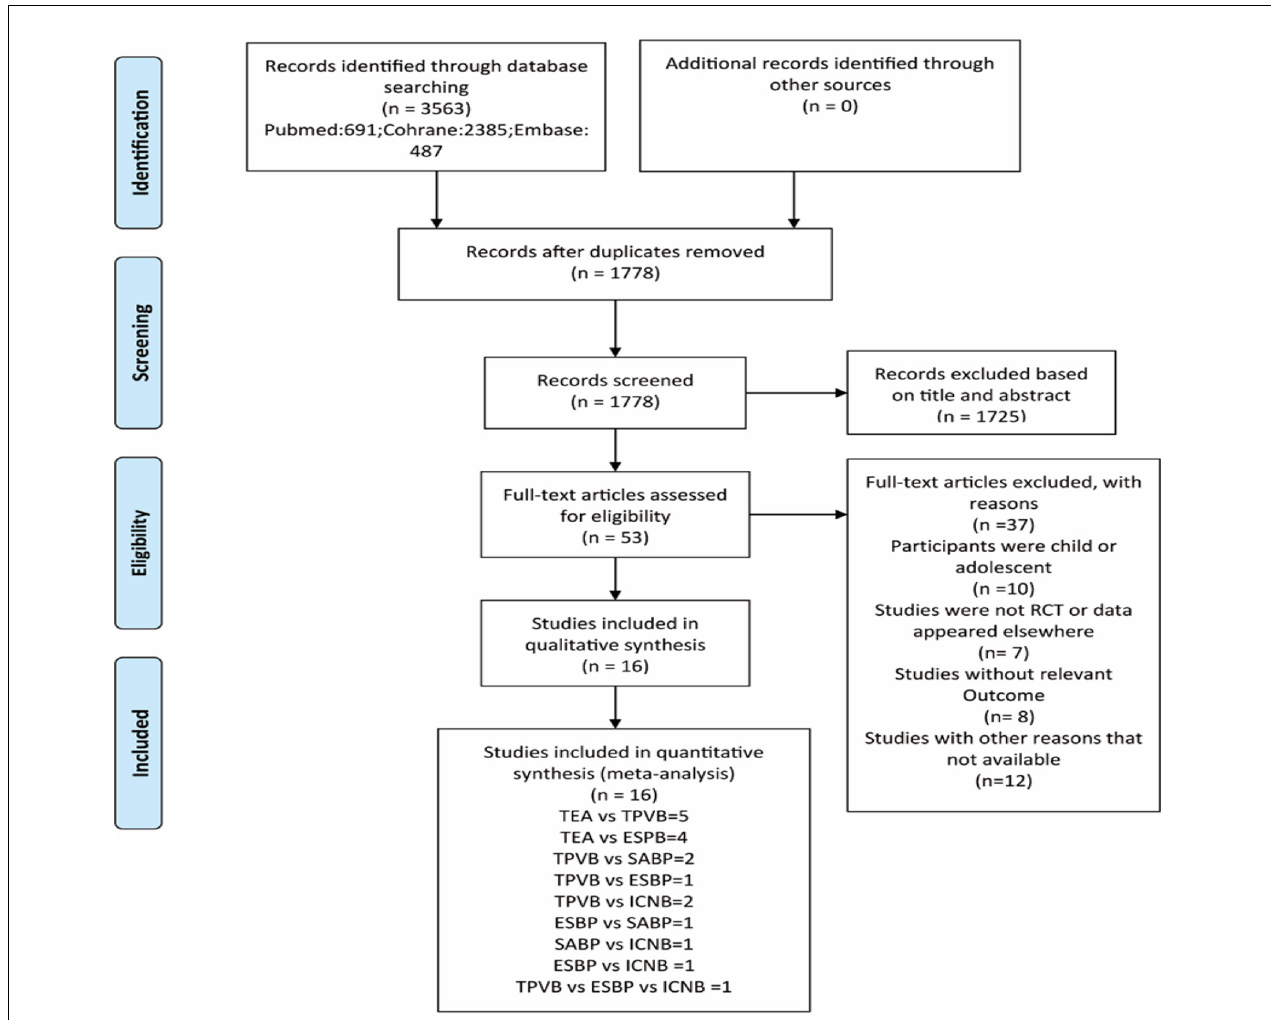
FIGURE 1 | Flow chart. TEA epidural block; TPVB paravertebral block; SABP serratus anterior plane block; ESPB erector spinae plane; ICNB intercostal nerve block; RCT, Randomized controlled trials. PRISMA flow diagram for the literature search with reasons for